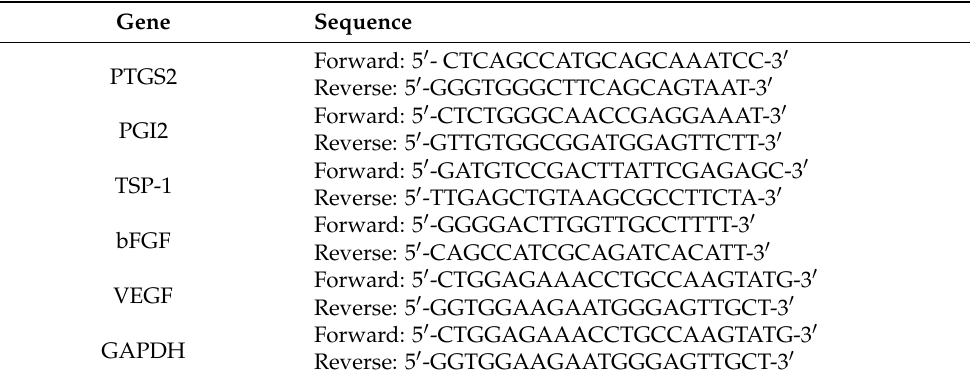
Table 1. The primer sequences for